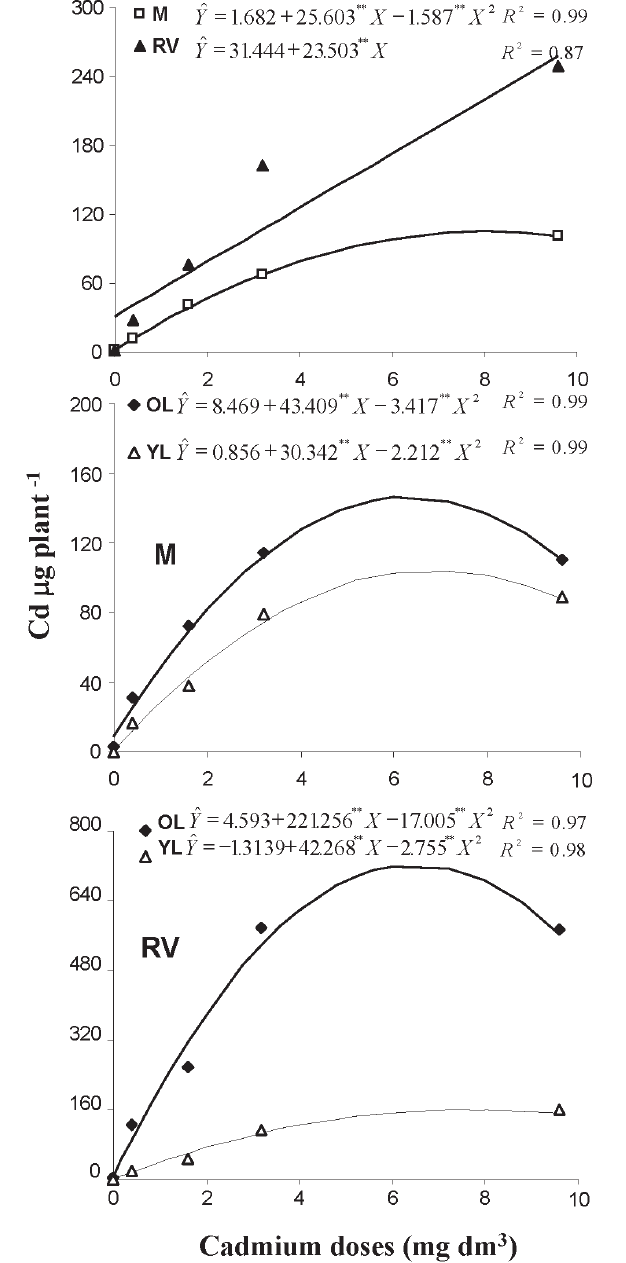
Figure 3 - Cadmium contents in in roots of Mimosa-M and Regina Verao-RV cultivars and in young leaves-YL and old leaves-OL of Mimosa-M and Regina Verao-RV, as a result of Cd doses applied to soil (plants were grown for 44 days in the Cd amended